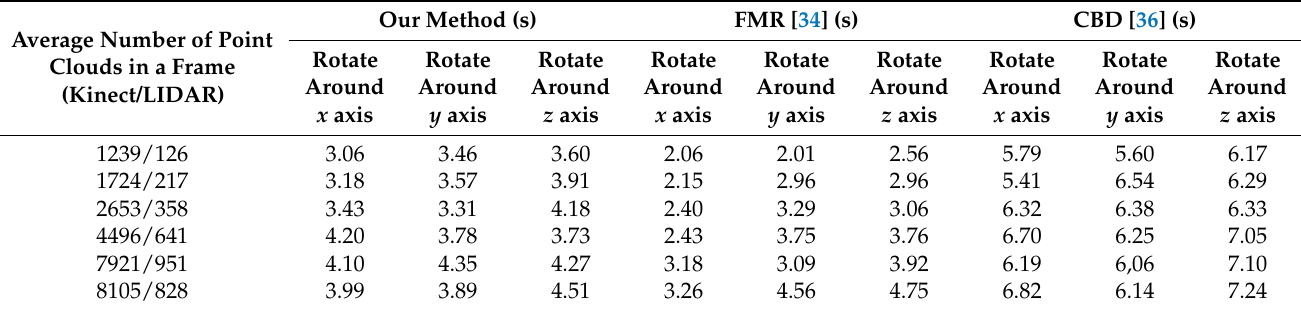
Table 6. Algorithm average running